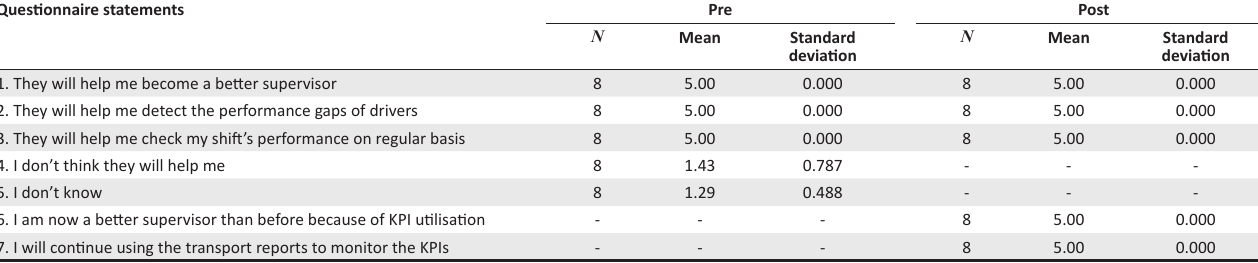
TABLE 3: The importance of key performance indicators. Questionnaire